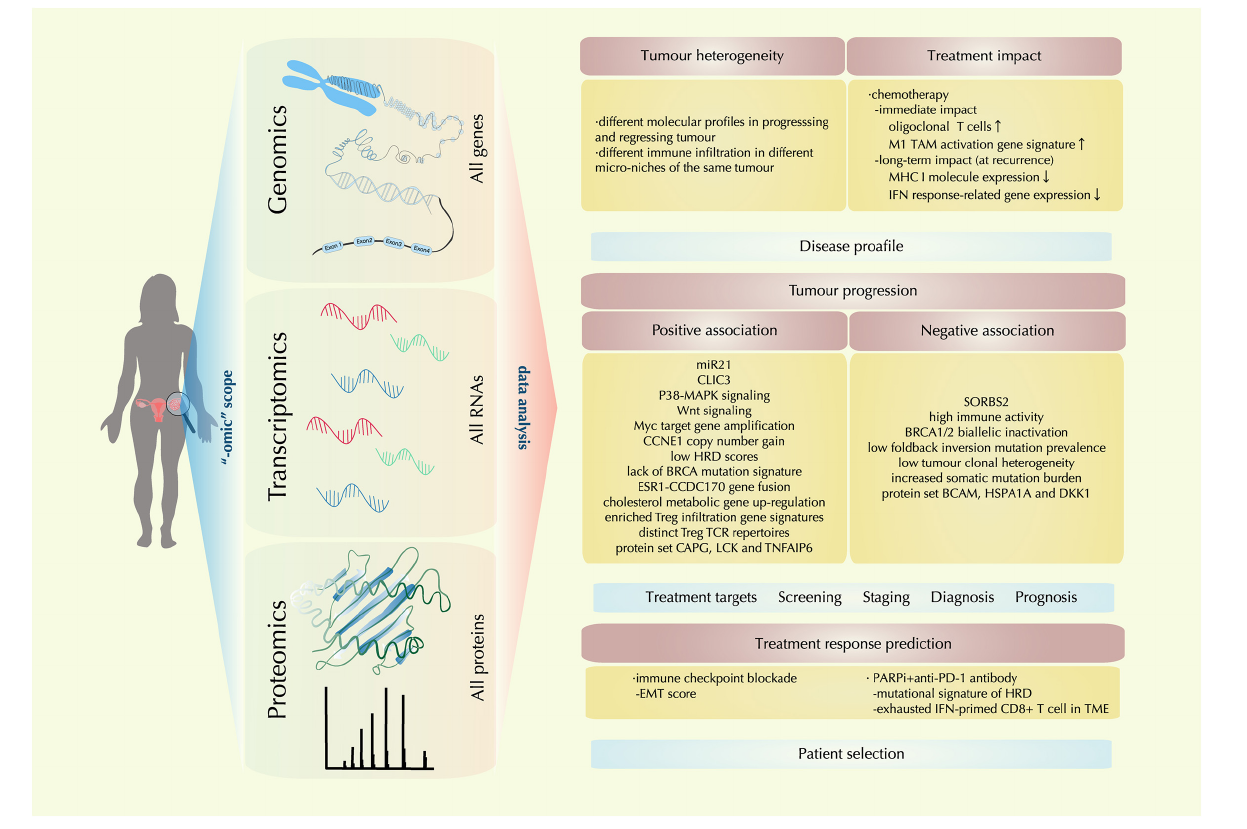
FIGURE 2 | Recent molecular findings by “-omic technology” in the ovarian cancer tumor microenvironment (TME). With the tools of genomic, transcriptomic, proteomic technology, a comprehensive multi-level landscape of ovarian cancer TME is revealed. With data are drawn from the “-omic scope,” the molecular profile of ovarian cancer is further identified in terms of tumor heterogeneity and treatment impact; new discoveries on factors that are either positively or negatively associated with tumor progression are also identified, providing clues for treatment target exploration and novel biomarker designing for disease screening, staging, diagnosis, and prognosis; also, correlations between certain therapeutic regimens and ovarian cancer TME profiles are investigated, providing implication for precision medicine by precise patient